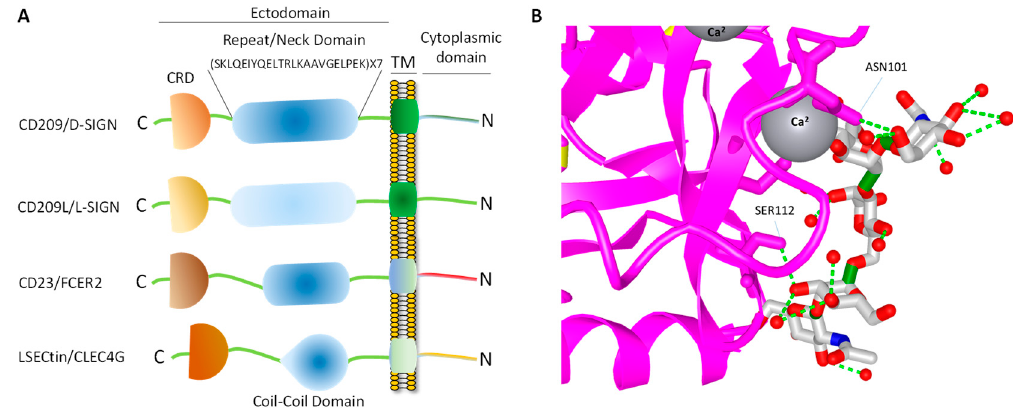
Figure 1. CD209 family proteins. ( A ) Graphic presentation of CD209 family proteins and the key domain information. The schematic of domains do not directly correlate to the number of amino acids in each domain. ( B ) Crystal structure of a typical CRD complexed with carbohydrate and the position of the Ca 2+ ion, which makes a tertiary complex between lectin and carbohydrate structure .